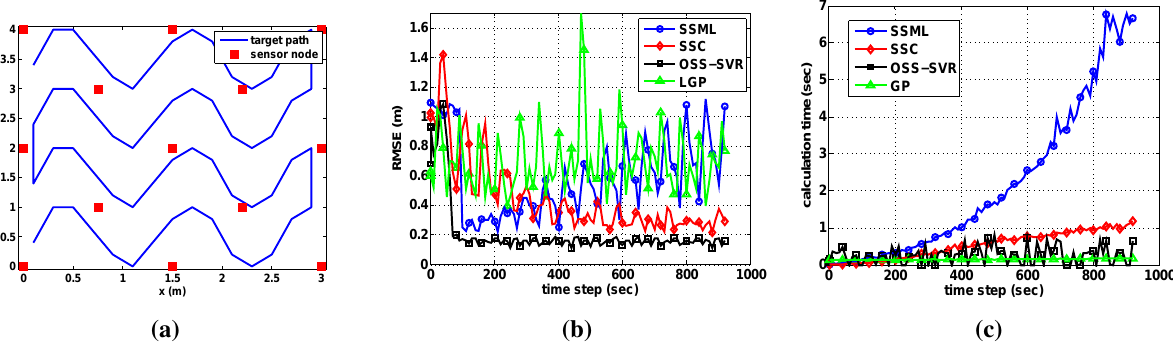
Figure 5. Localization performance of a sinusoidal trajectory, when we apply a decremental algorithm to each method in order to limit the amount of training data. ( a ) Target path; ( b ) localization error; and ( c ) calculation